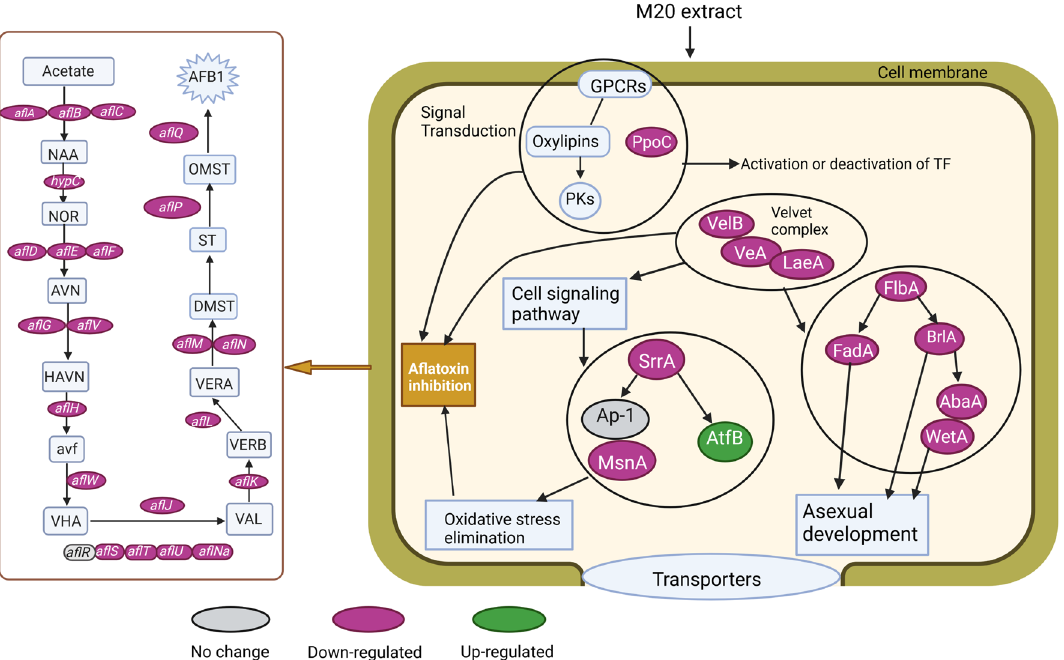
Figure 6. Schematic illustration of the anti-aflatoxigenic mechanism of M20 extract. In our working model, the extract causes downregulation of oxylipin-dependent cellular signaling, cellular development, the secondary metabolism regulator Velvet complex, and the oxidative stress pathway. Changes induced by M20 cause inactivation of the AF biosynthesis genes that mediate these processes, leading to a lack of the enzyme machinery required to produce AFs. PKs protein kinases, TF transcription